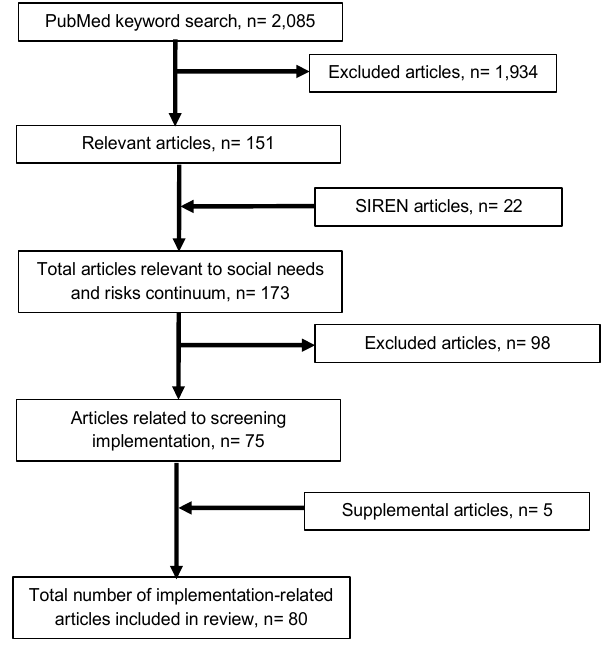
Figure 2. Flow diagram of literature review search results. SIREN, Social Interventions Research & Evaluation